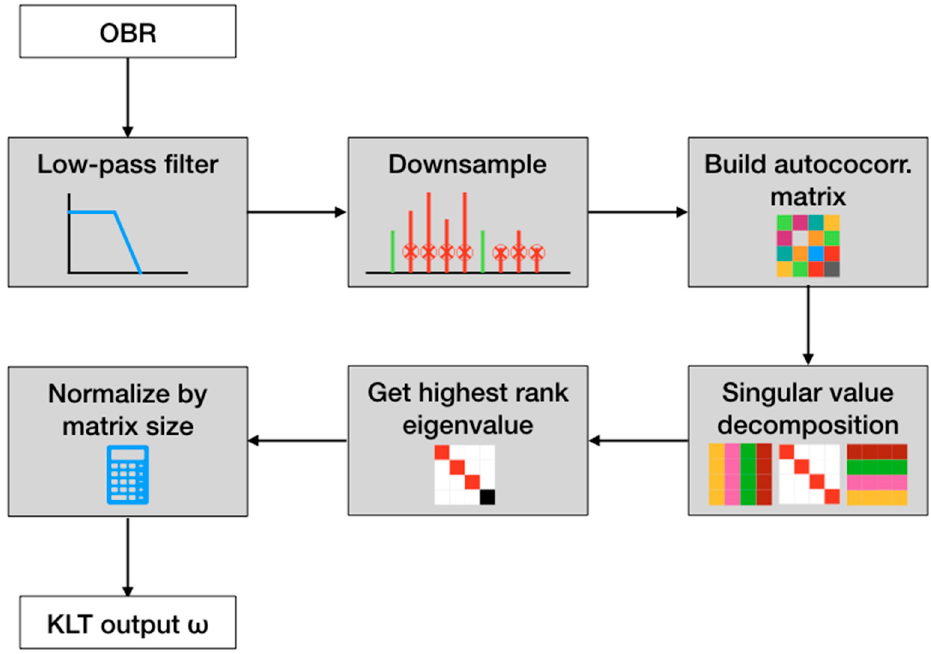
Figure 3. A flow chart of the undersampled KLT is used to demodulate the spectrum of the ball resonators.